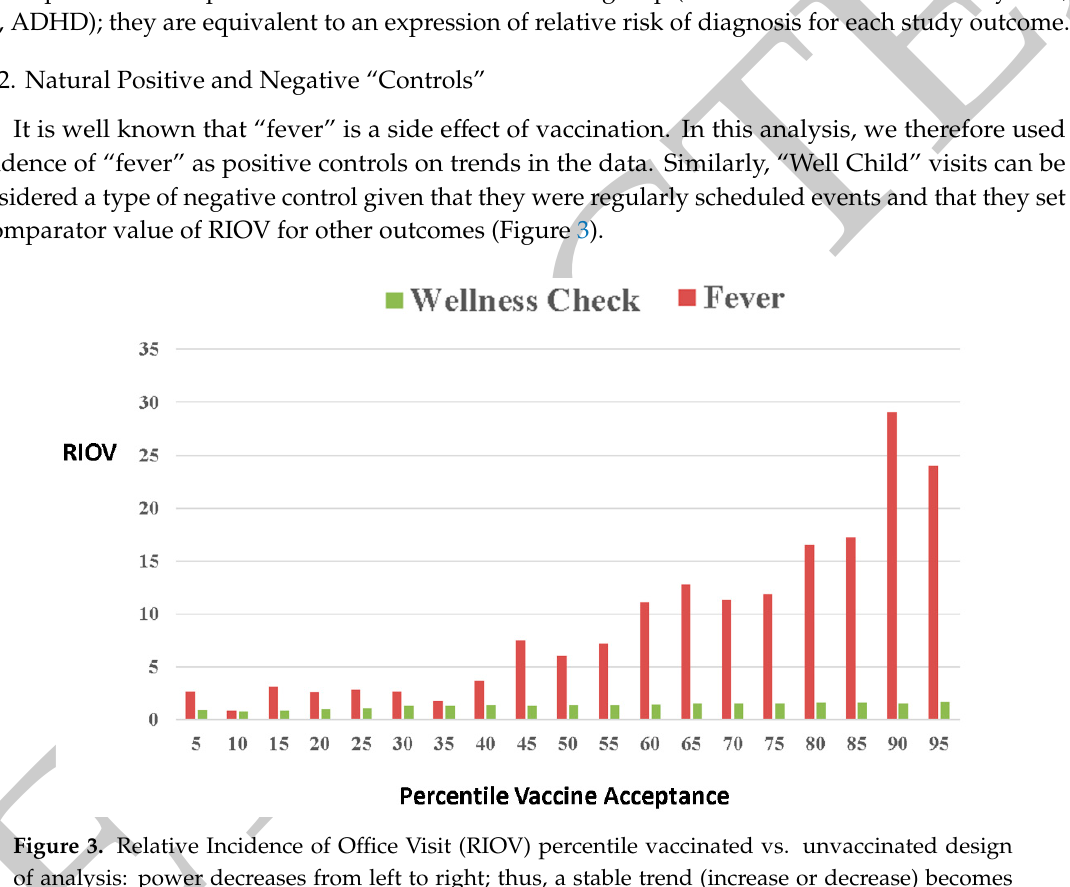
Figure 3. Relative Incidence of Office Visit (RIOV) percentile vaccinated vs. unvaccinated design of analysis: power decreases from left to right; thus, a stable trend (increase or decrease) becomes noteworthy. The data shown are for the Relative Incidence of Office Visits (RIOVs) to average incidence ratio of billed office visits related to fever in the vaccinated compared to the unvaccinated ( OV V /OV UV ) conditions and for “Well Child” visit on the right. For all the clinical conditions studied, RIOV reflects the total number of billed office visits per condition per group, reflecting the total disease burden on the group and the population that it represents.